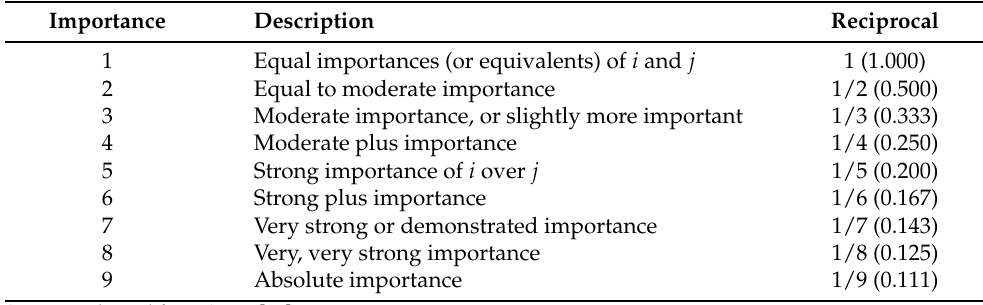
Table 1. Fundamental scale of factors in pairwise